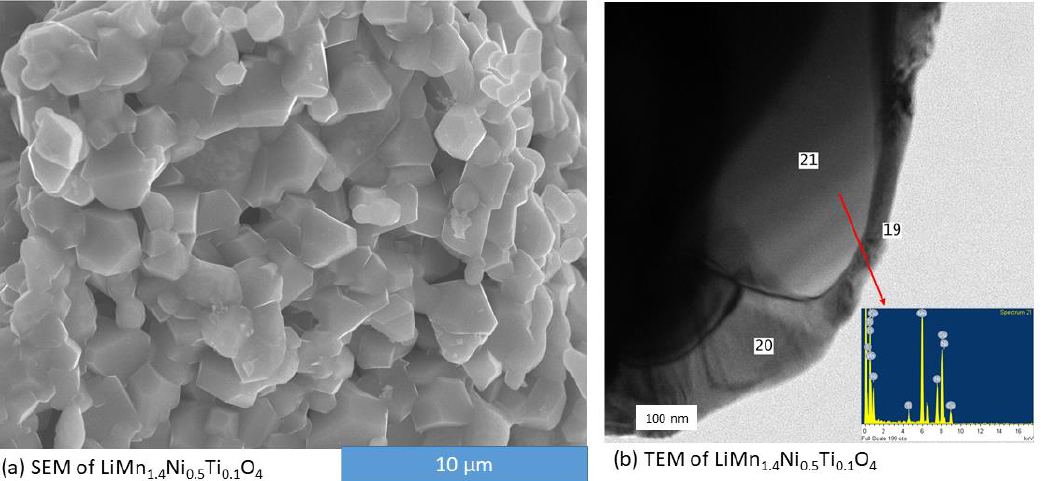
Figure 2. ( a ) SEM image and ( b ) TEM image and (inset) EDX of synthesized LMn 1.5 − x Ni 0.5 Ti x O (x =